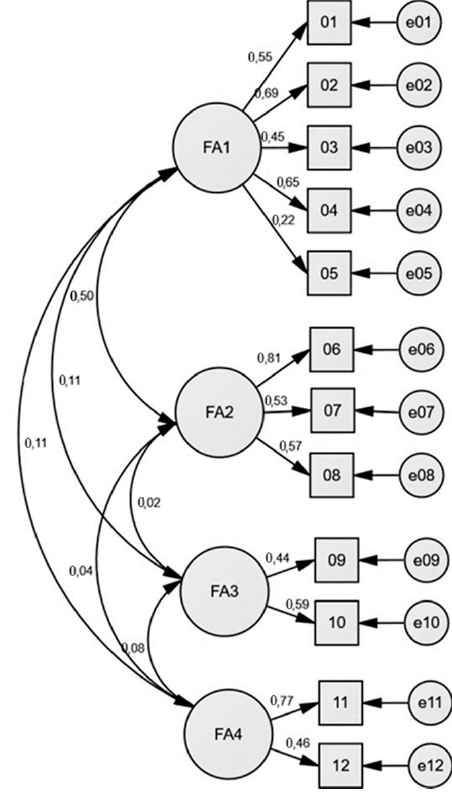
Figure 2. The four-factor model diagram with standardised estimates.